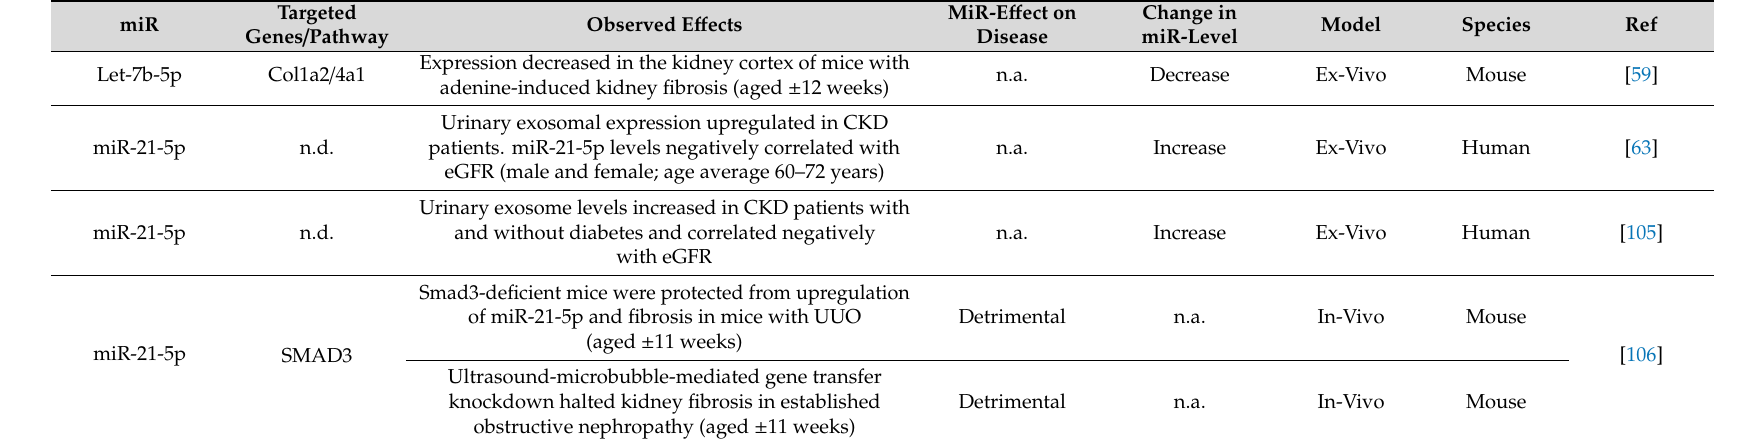
Table 5. Overview of miRs that are involved in kidney fibrosis and CKD (only ex-vivo / in-vivo